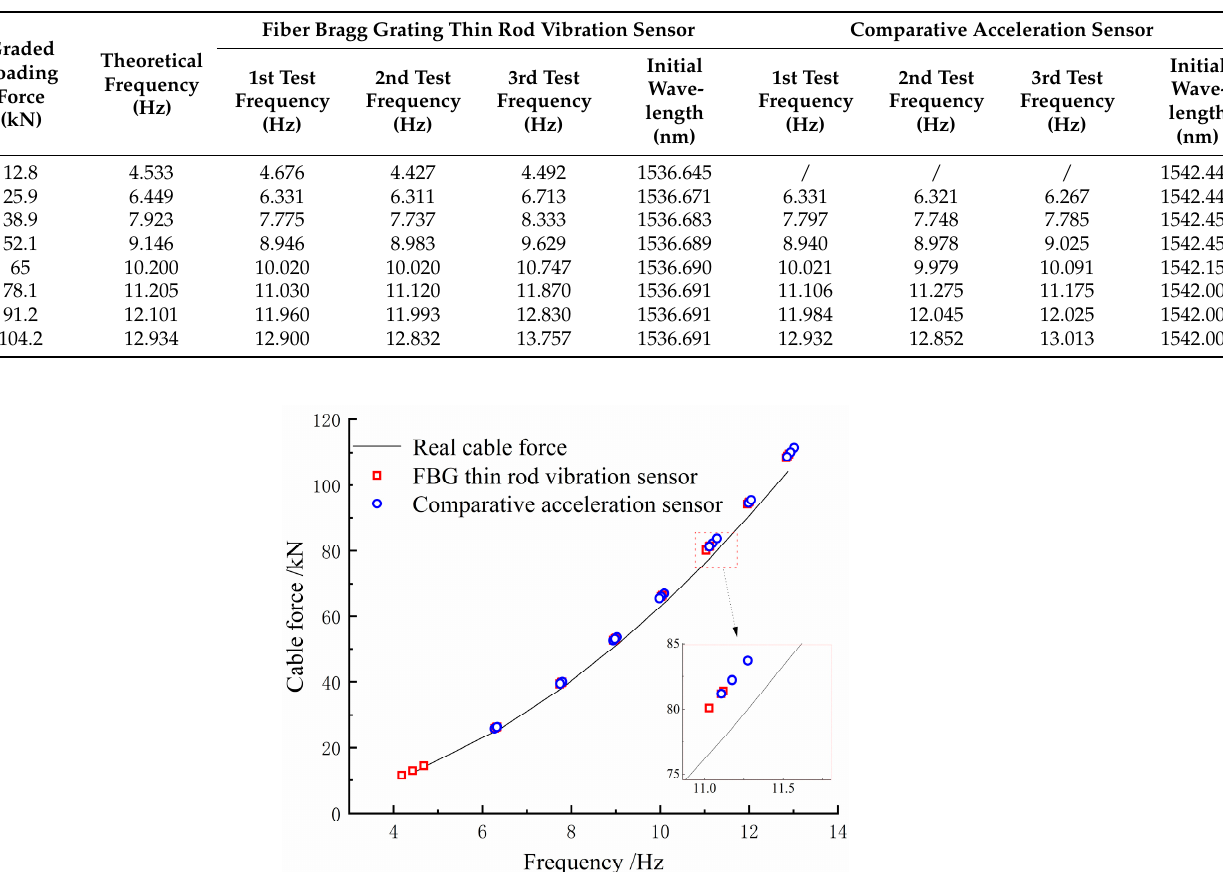
Table 1. Indoor cable tension test data.